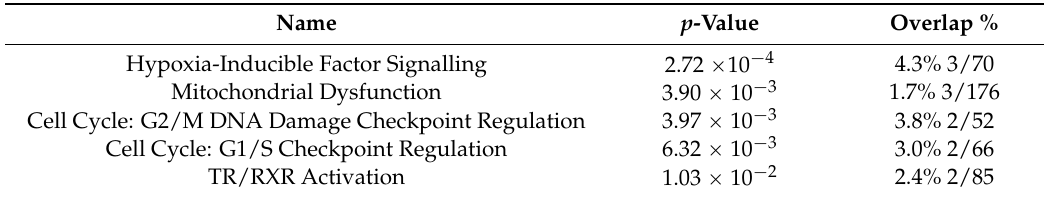
Table 5. Top Toxicological Lists for LAP1 interactors